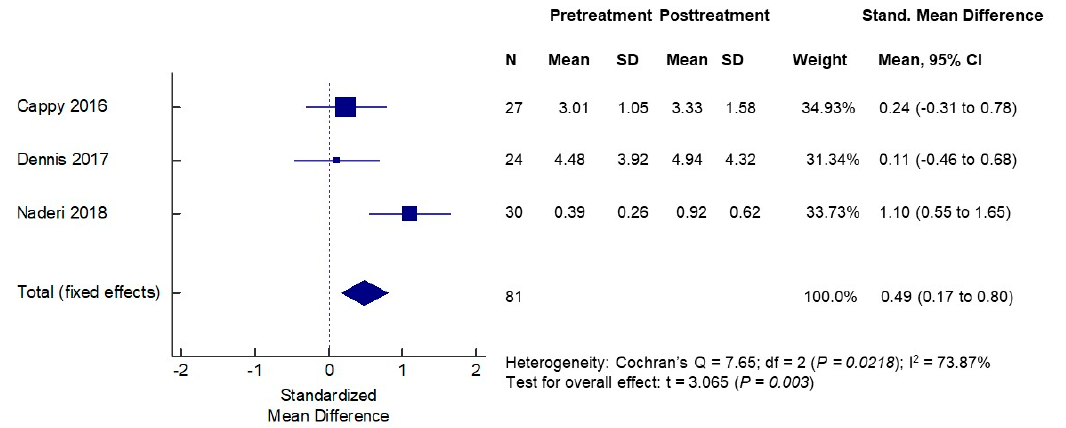
Figure 5. Effects of vitamin D supplementation on serum AMH levels—non-PCOS women.